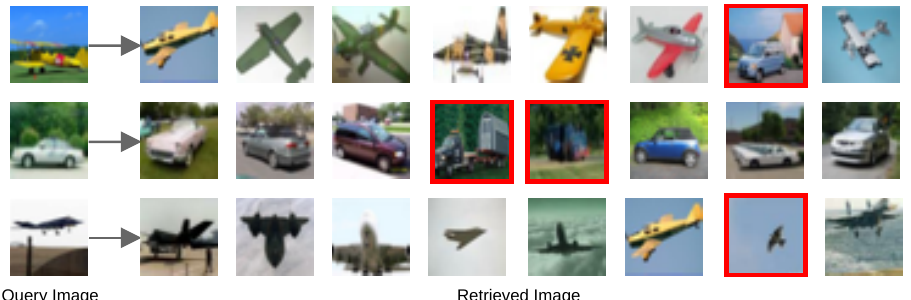
Figure 9. The figure depicts an inference of the query and the retrieved images. Each row represents a query and the corresponding retrieved images. Red bounded images are faulty